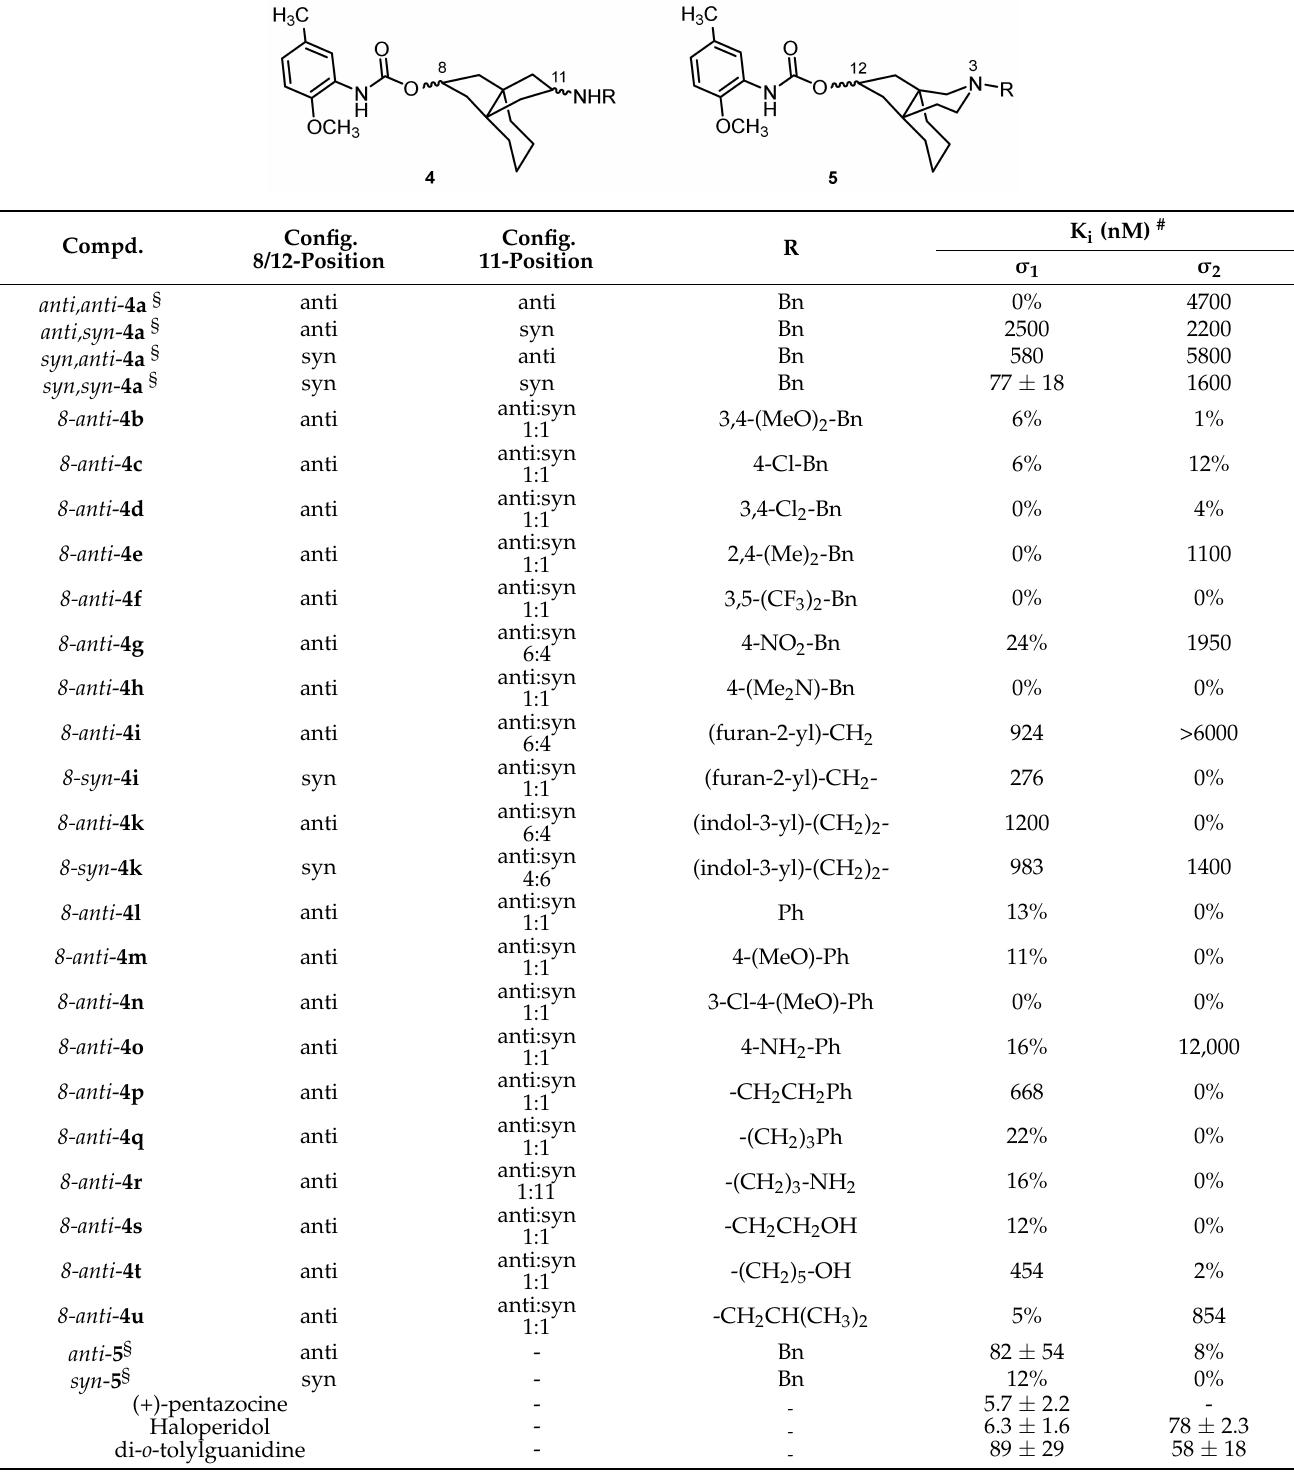
Table 1. Affinities of propellanylcarbamates 4 and 5 towards σ 1 and σ 2